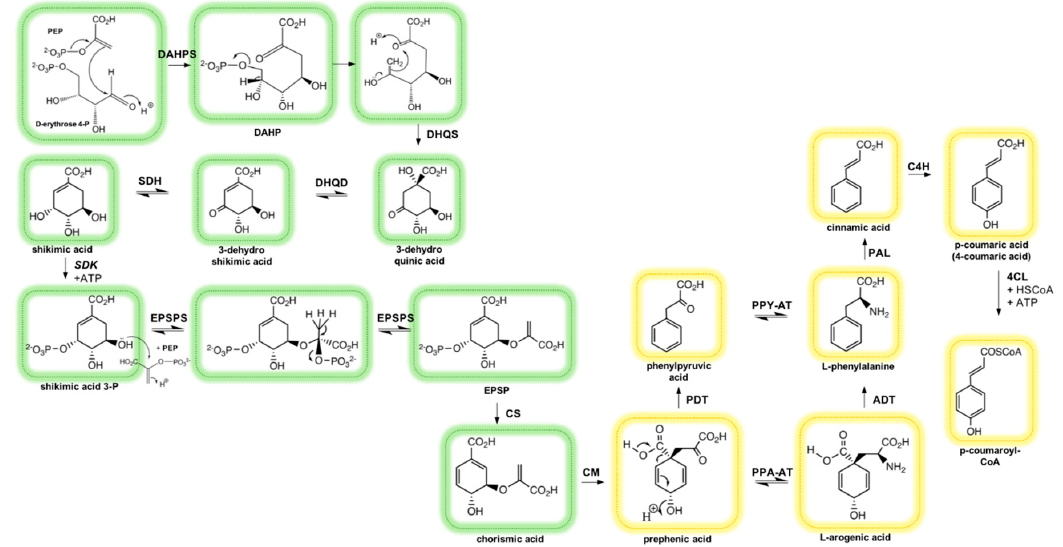
Figure 3. Interplay of shikimate and phenylpropanoid pathway. A detailed description can be